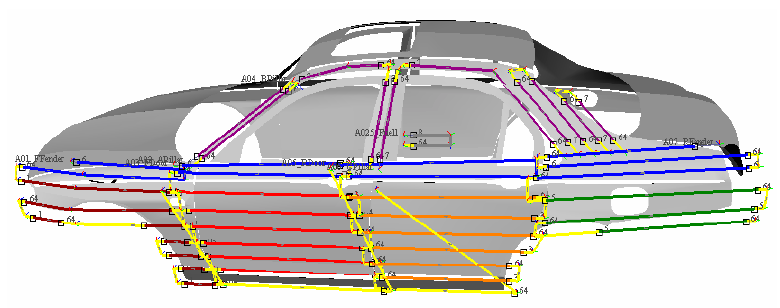
Figure 14. Spray Painting trajectory on the roof and rear part of the automobile.